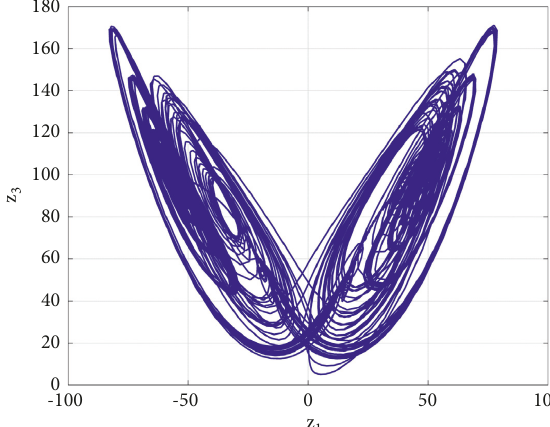
Figure 10: A hyperchaotic attractor of the model (1) for b � 10 and ( a,c, d ) � ( 25 , 90 , 6 ) .